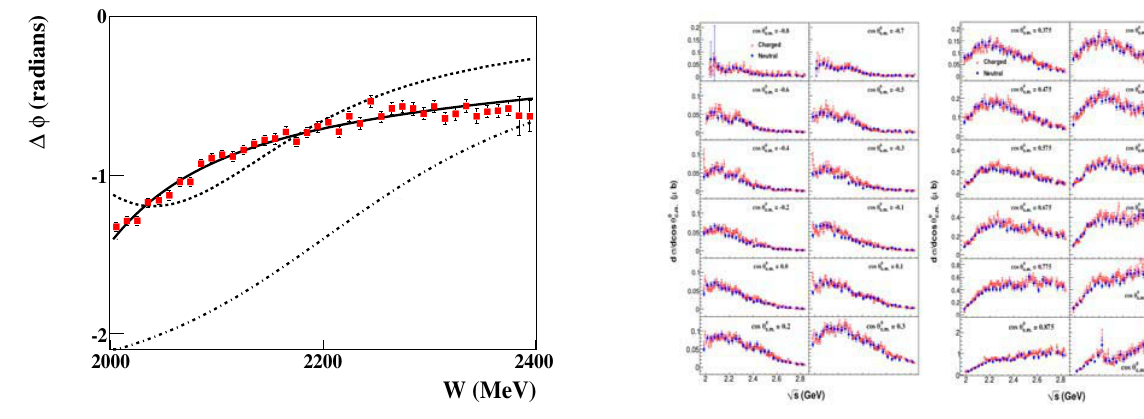
Fig. 10 Differential cross sections in a nearly full angular range for γp → pφ